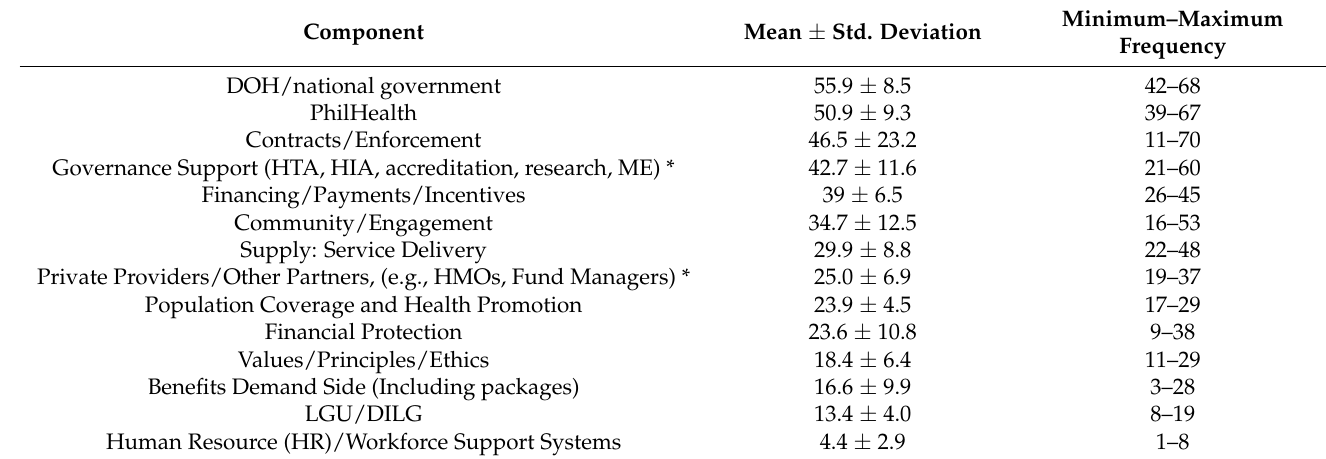
Table 3. Average number of tags for 14 components in the UHC Act by seven